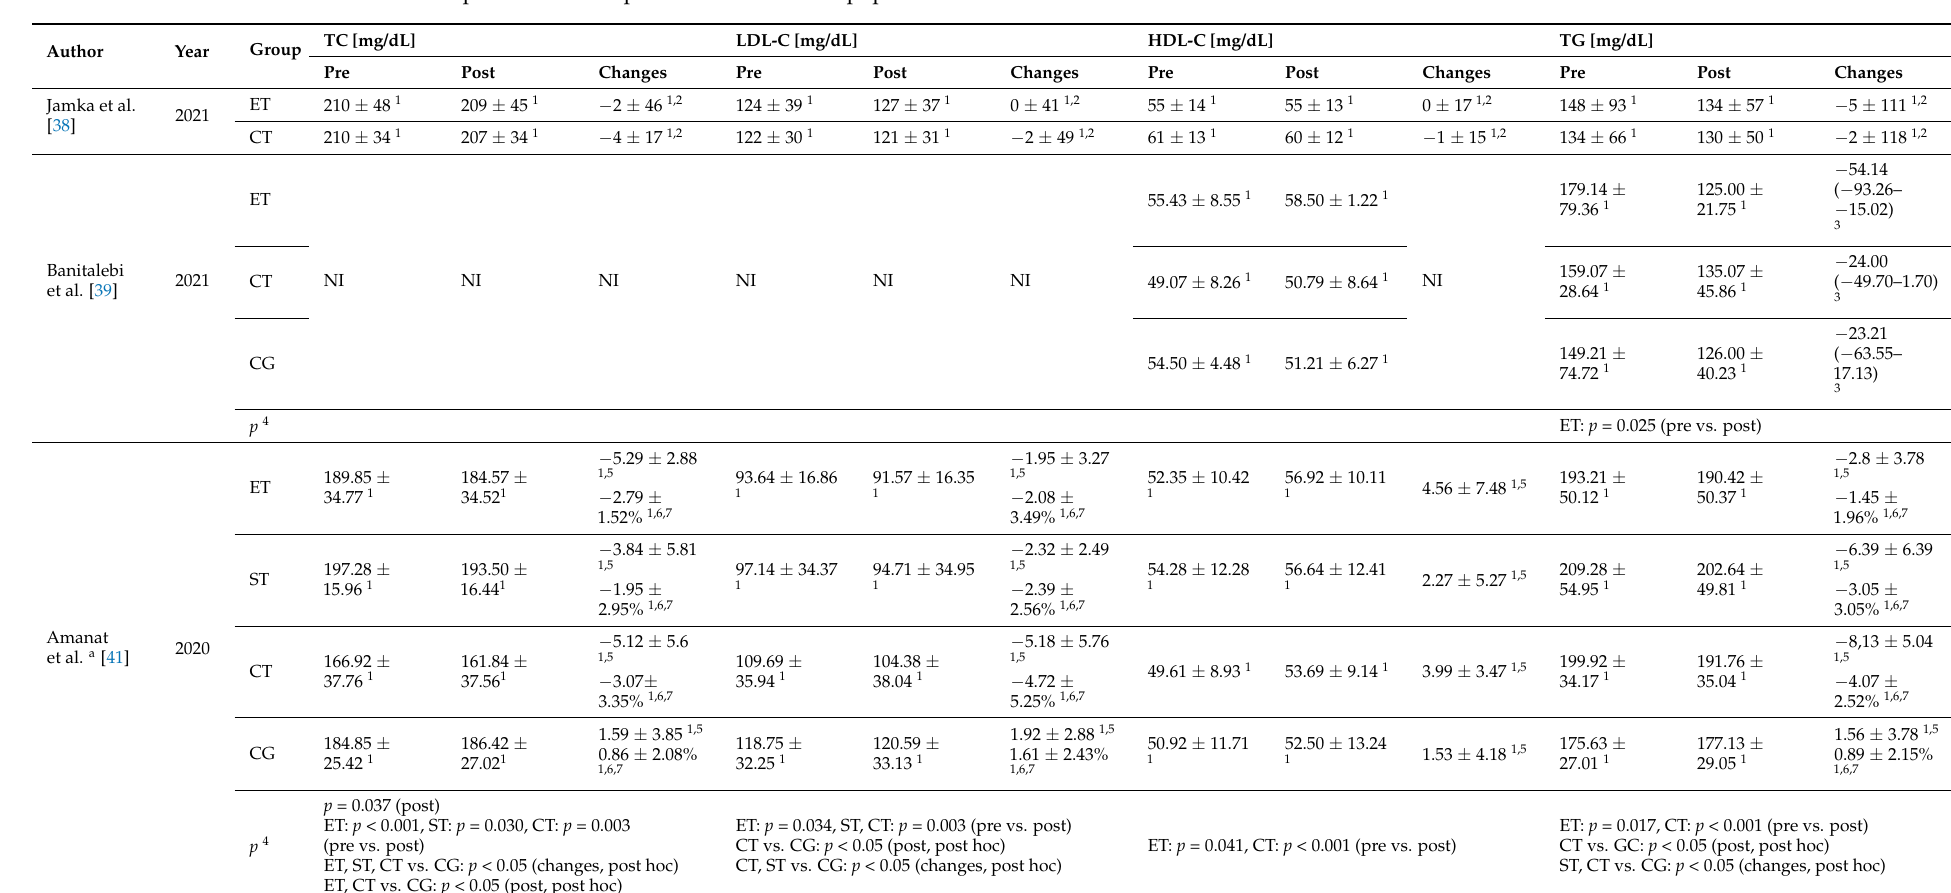
Table 5. Lipid metabolism parameters in studied